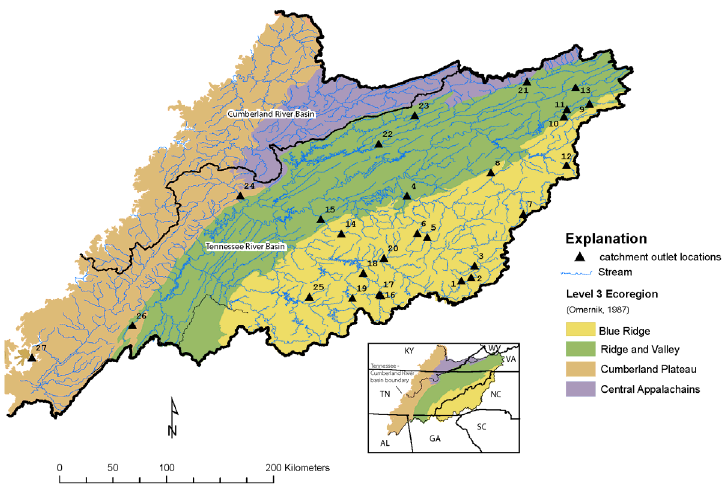
Figure 1. Catchment outlet locations for 27 basins modelled using 7 calibration schemes for